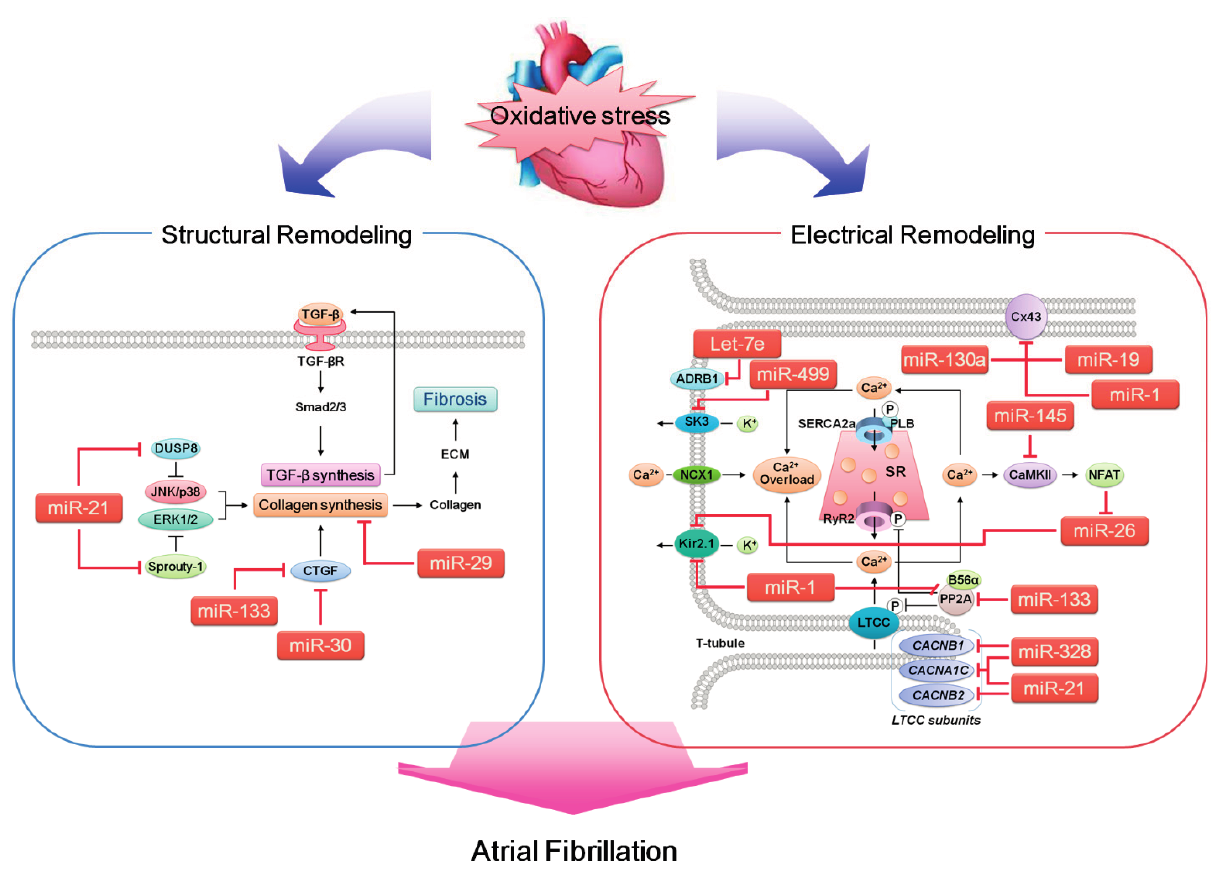
Figure 1. Concept of the ROS–miRNA–AF